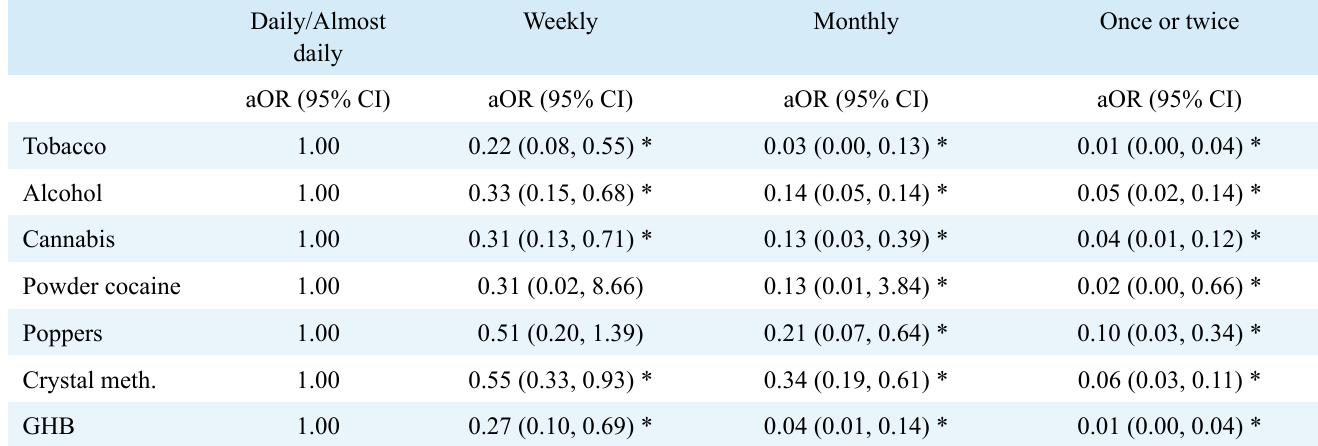
TABLE 3. Multivariable ordinal regression results examining association between frequency of drug use and readiness to act among sexual minority men and non-binary people who use crystal methamphetamine.